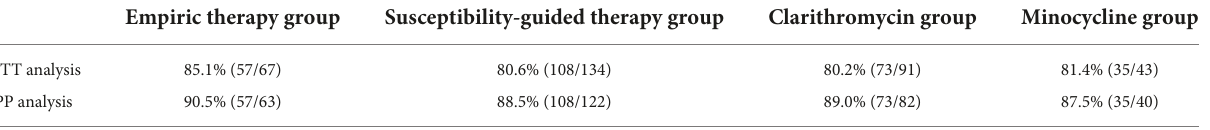
TABLE 2 Eradication rate of each group in intention-to treat (ITT) and per-protocol (PP)